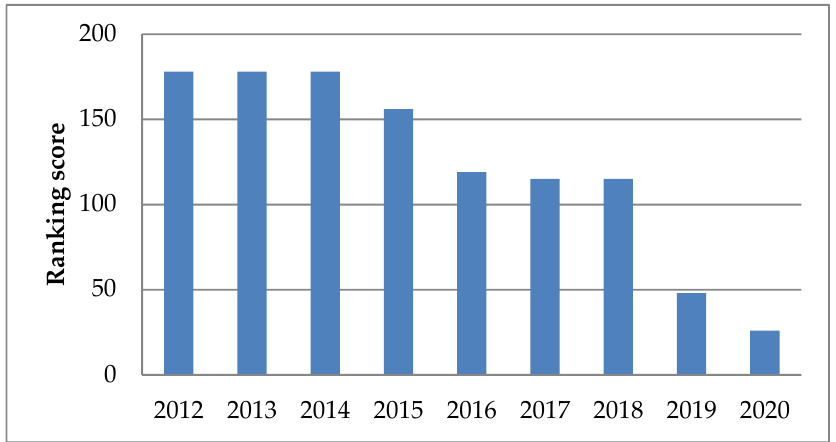
Figure 1. Russian Federation ’ s score in the World Bank ’ s Doing Business ranking titled “ Dealing with Construction Permits ” (2012 – 2020).